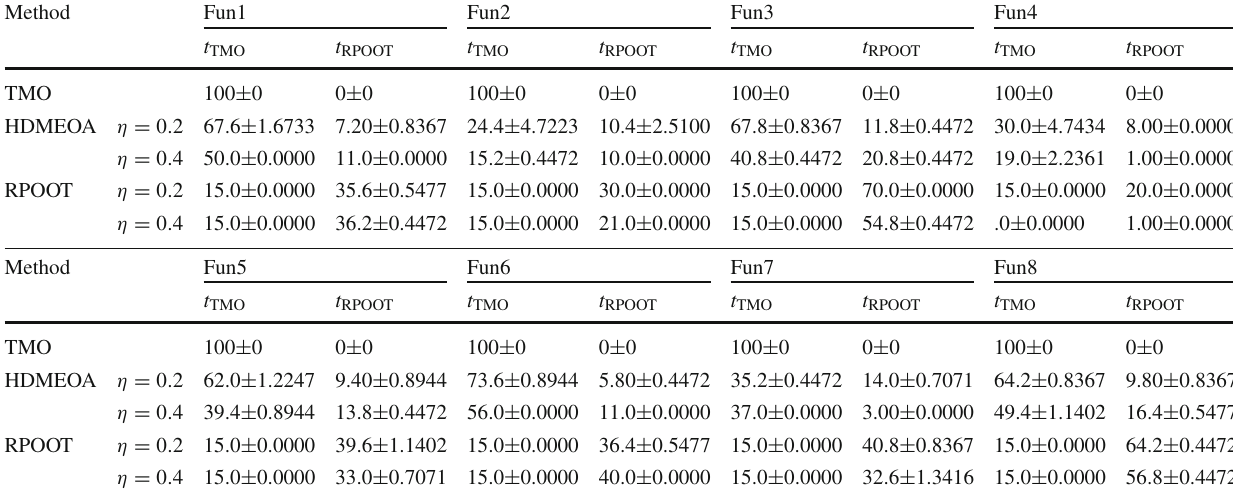
Table 8 NumTR comparison of three methods under chaotic environmental